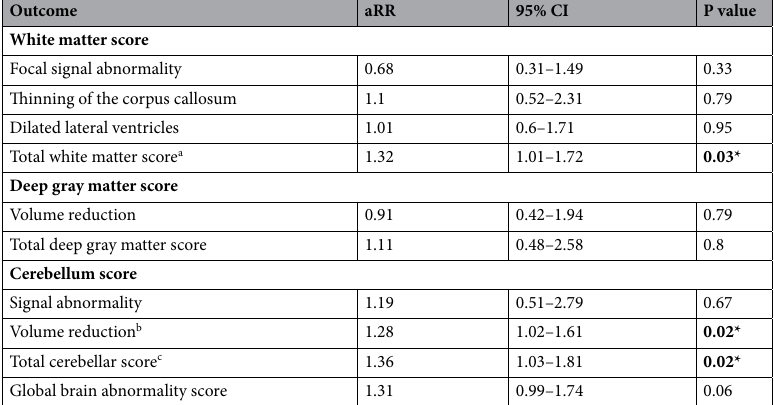
Table 3. Multivariable regression of global brain abnormalities score on TEA-MRI in relation to morphine exposure in first week of life (n = 106). Significant values are in bold. aRR adjusted relative risk, CI Confidence interval. *Statistically significant at 5% level. a aRR were adjusted for IVH, inotropes, and total invasive ventilator days. b aRR were adjusted for gestational age, birth weight, IVH, inotropes, hydrocortisone, age at MRI, pulmonary hemorrhage, total invasive ventilator days and PDA. c aRR were adjusted for gestational age, birth weight, antenatal steroid treatment, IVH, inotropes, hydrocortisone, age at MRI, pulmonary hemorrhage, total invasive ventilator days and